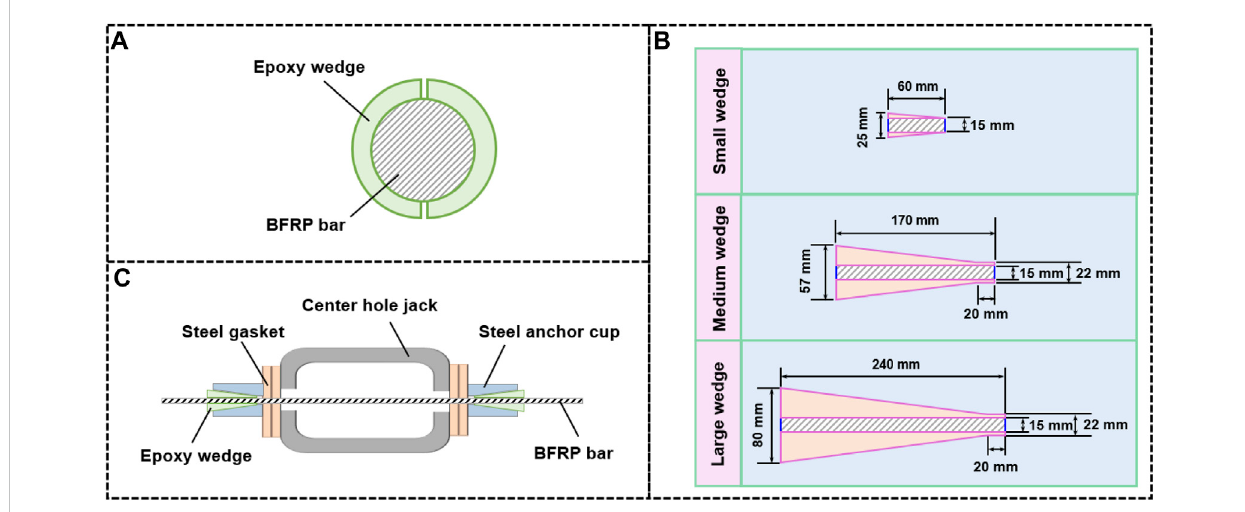
FIGURE 2 Structure of key components in the TSAS and the corresponding tension device: (A) Wedge holding methods in WMAS, (B) Epoxy wedges with different sizes, (C) Tension device of the TSAS.